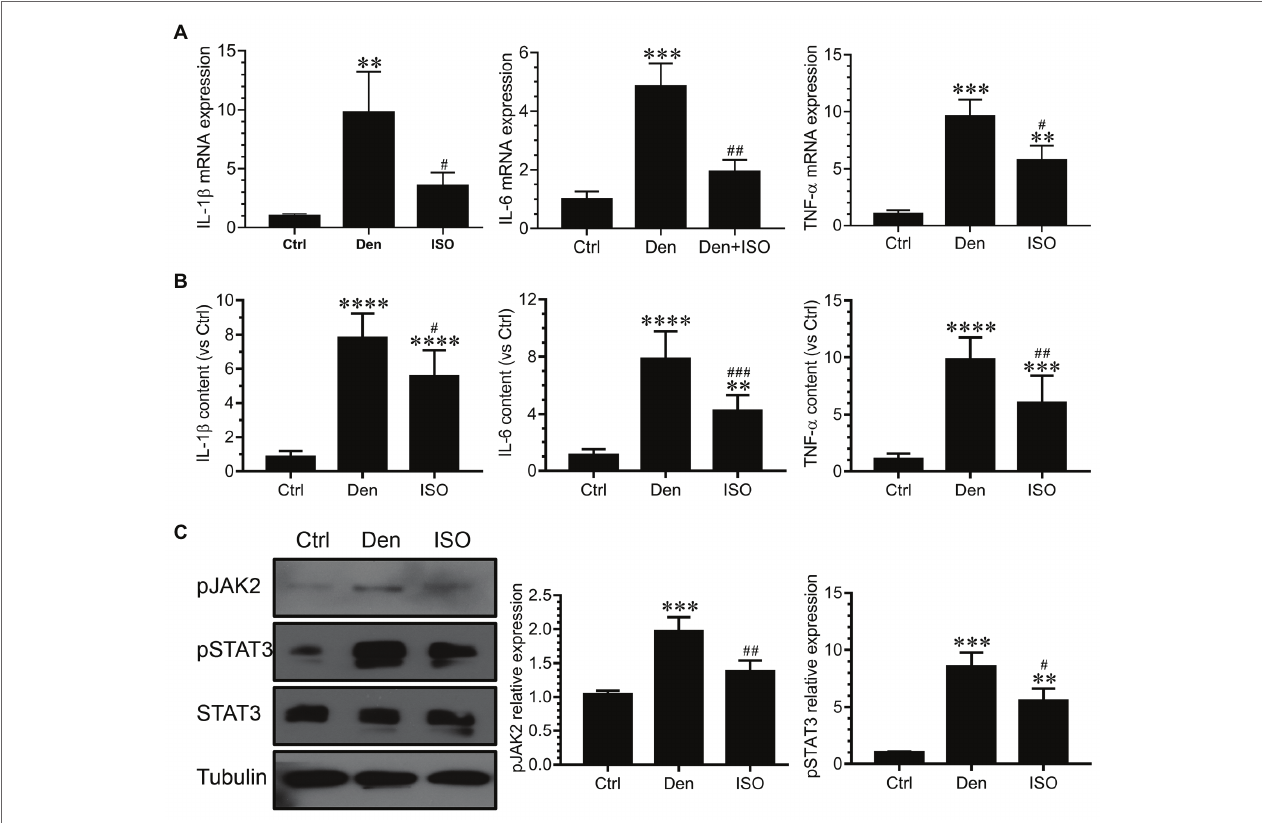
FIGURE 5 | Isoquercitrin inhibits the inflammatory response in denervated soleus muscles ( n = 6). (A) Quantitative polymerase chain reaction detection of changes in the expression of the inflammatory factors interleukin (IL)-1 β , IL-6, and tumor necrosis factor (TNF)- α . (B) Enzyme-linked immunosorbent assay (ELISA) detection of the expression of IL-1 β , IL-6, and TNF- α ; (C) Western blot analysis of JAK/STAT3 activation. Ctrl, control group; Den, denervation group; ISO, denervated target muscle plus isoquercitrin (20 mg/kg/d) group. ** p < 0.01, *** p < 0.001, and **** p < 0.0001 vs. Ctrl; # p < 0.05, ## p < 0.01, and ### p < 0.001 vs.